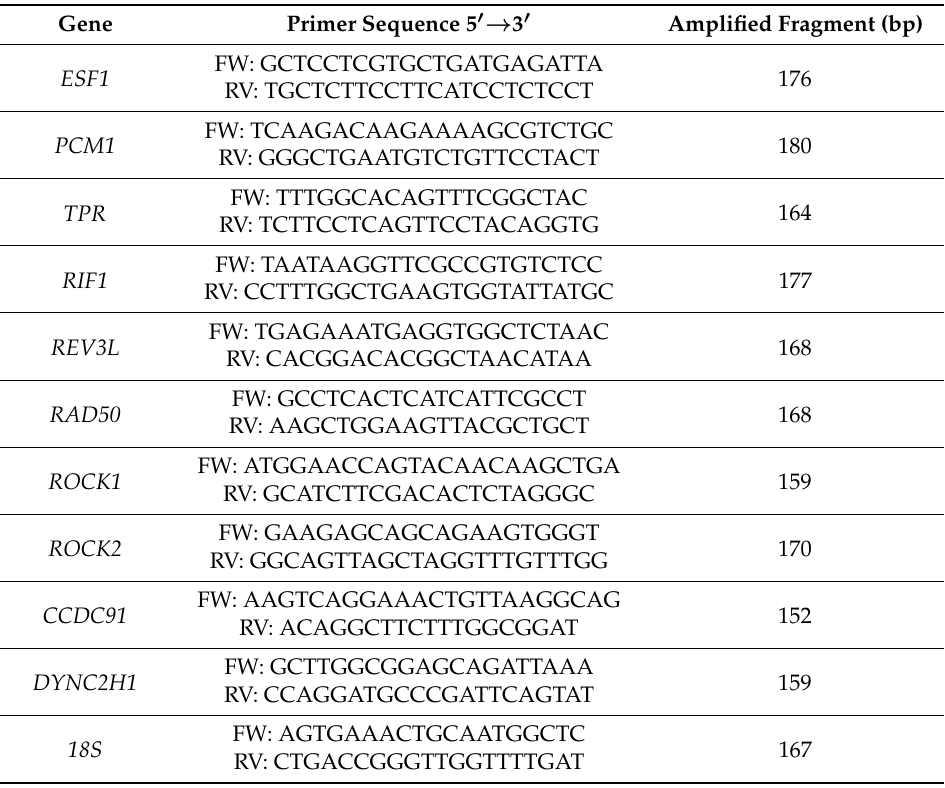
Table 2. Designed primers used for different gene